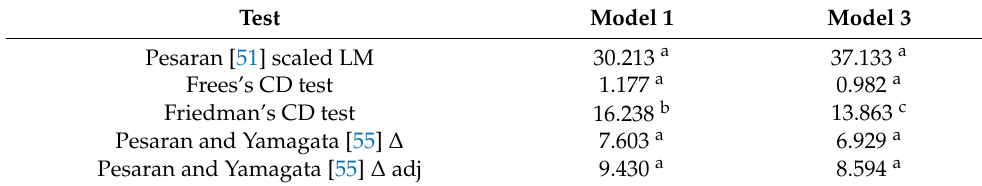
Table 3. Results of cross-sectional dependence (CD) and slope homogeneity